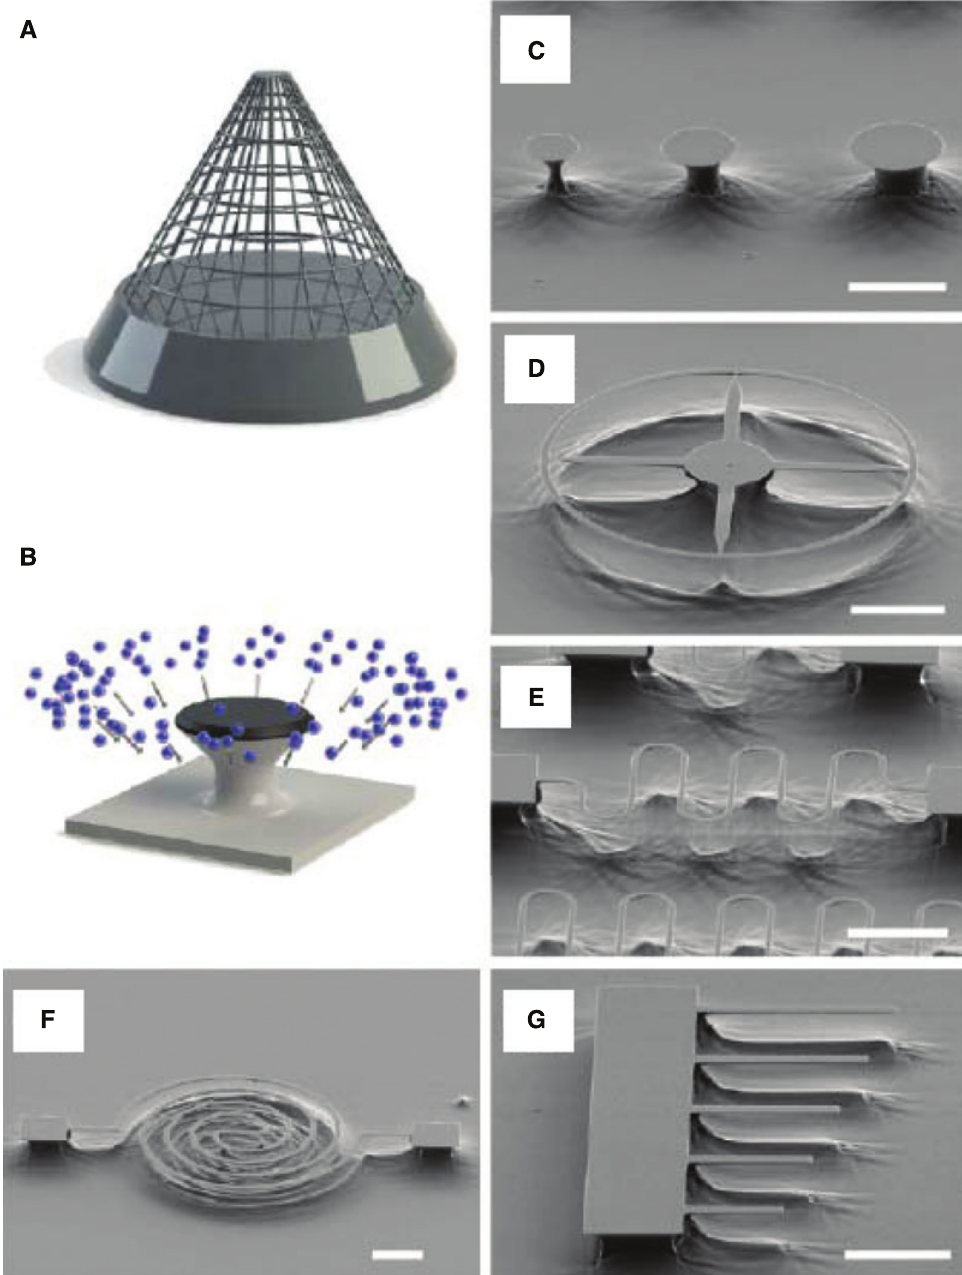
Figure 11: Schematic illustrations of (A) the conical Faraday cage used to carry out angled plasma etching (B) of the substrates. SEM images of (C) undercut various diameter microdisks; (D) ~ 500-nm wide nanoring structure; (E) ~ 500-nm wide curved and (F) ~ 750-nm wide spiral nanobeams; and (G) ~ 1- μ m wide nanobeam cantilevers. All SEM images were taken at a 60 ° stage tilt. Scale bars correspond to 5 μ m [104]. Reprinted with permission from [104]. Copyright 2012 American Chemical